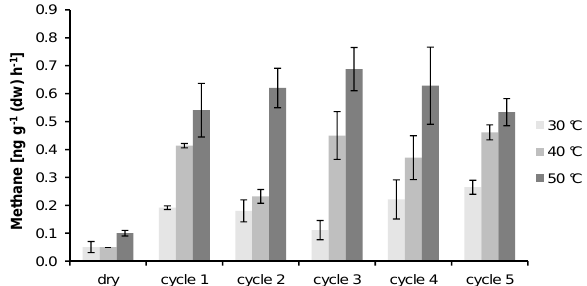
Fig. 2. Methane formation from wetted and dry peat samples. Effect of repeated wetting and drying cycles on CH 4 release from peat PH at 30, 40 and 50 ◦ C. Data show mean value ± SD ( n